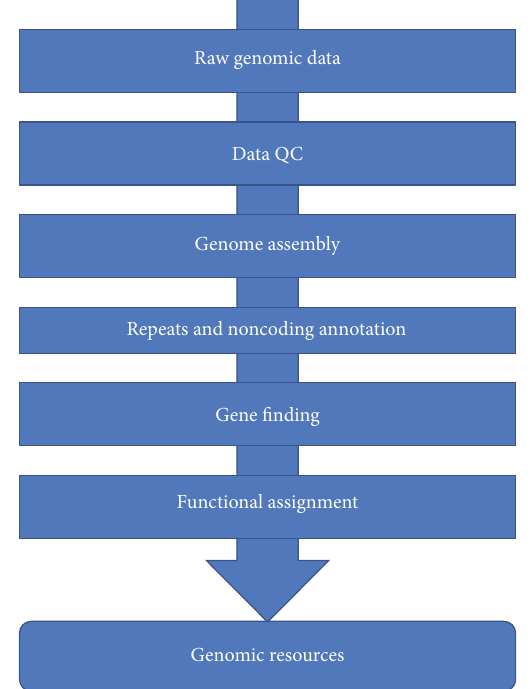
Figure 1: Overview of genomic resource development steps. Raw data is quality controlled and then assembled. Repeats and noncod- ing features are structurally annotated and used to mask the genome sequence. Genes are then called on this masked sequence, followed by functional assignment. Genome assembly, repeats, noncoding features, and genes constitute basic genomic